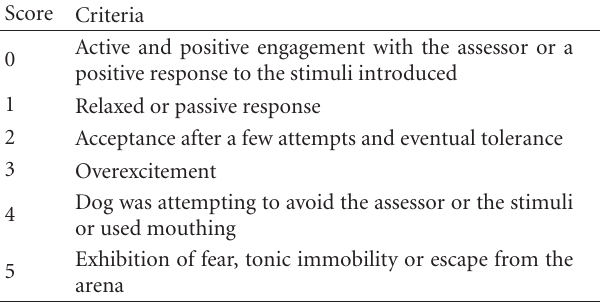
Table 1: Criteria for the scoring